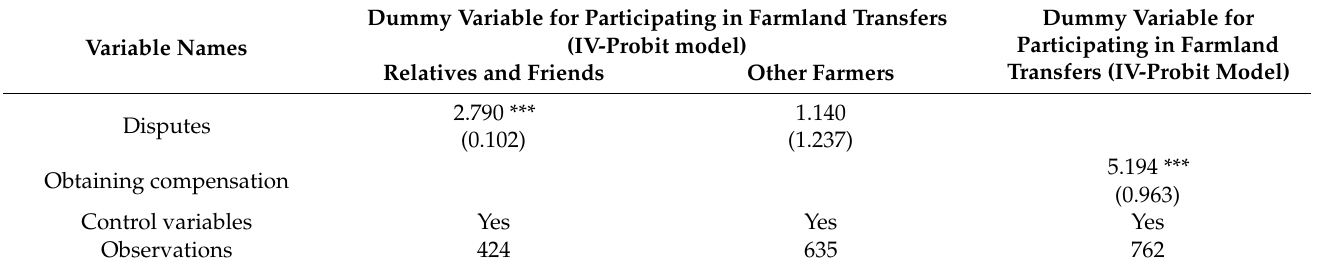
Table 5. Estimation results of instrumental variables.